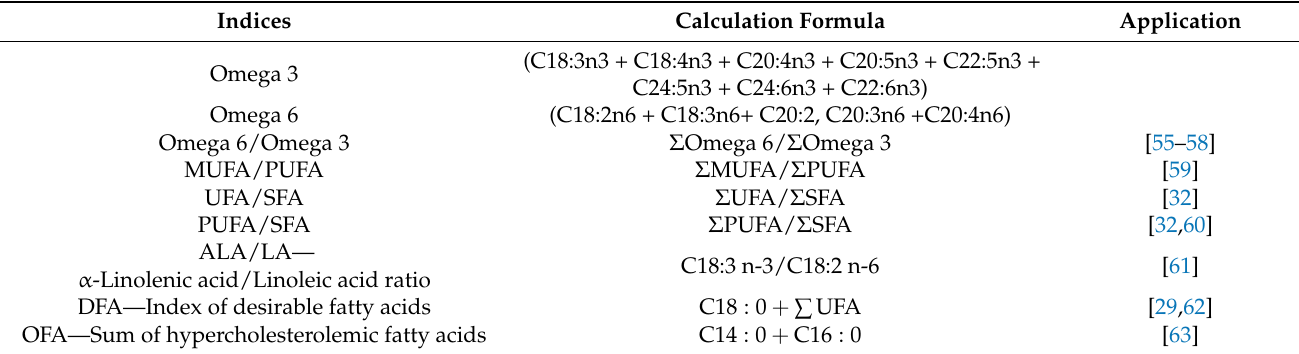
Table 2. The indicators of nutritional quality of soybean